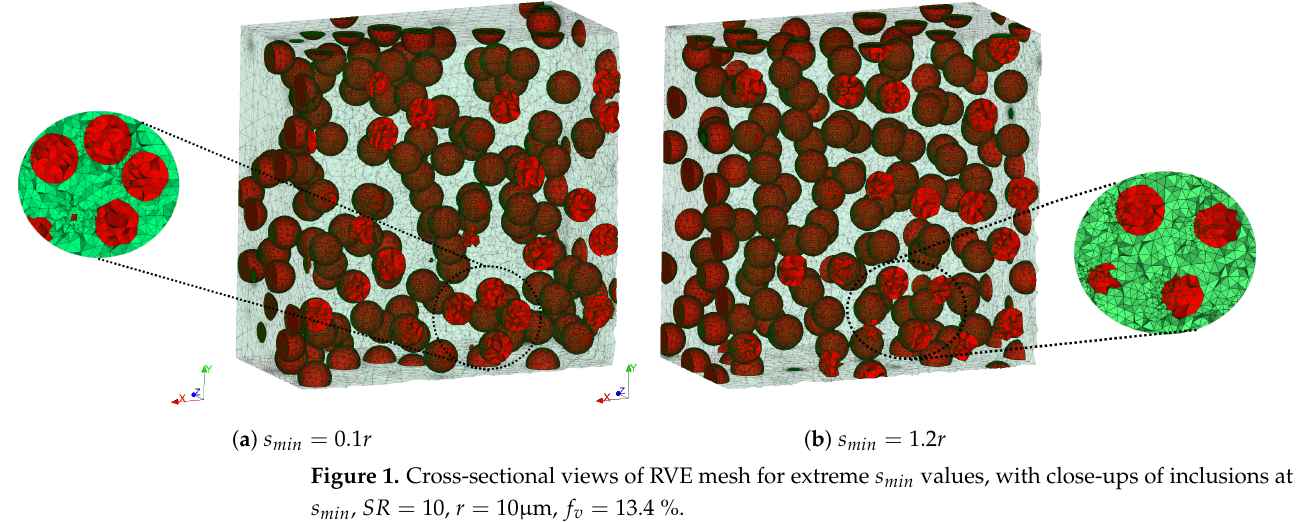
Figure 1. Cross-sectional views of RVE mesh for extreme s min values, with close-ups of inclusions at s min , SR = 10, r = 10 µ m, f v = 13.4 %.